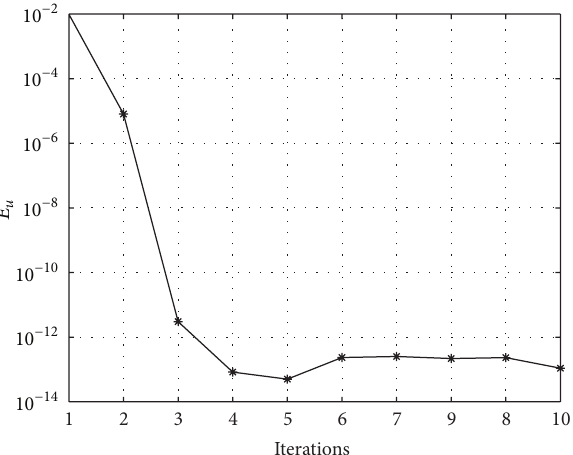
Figure 14: Burger-Fishers equation convergence graph.